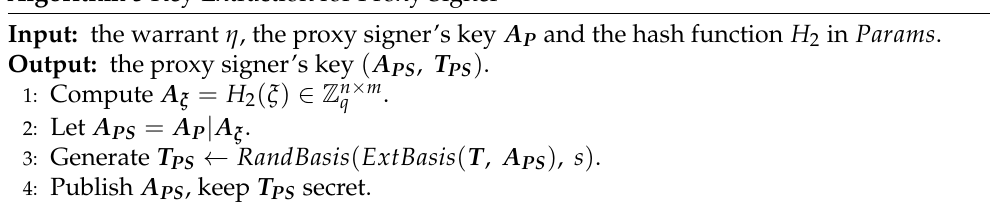
Algorithm 5 Key Extraction for Proxy